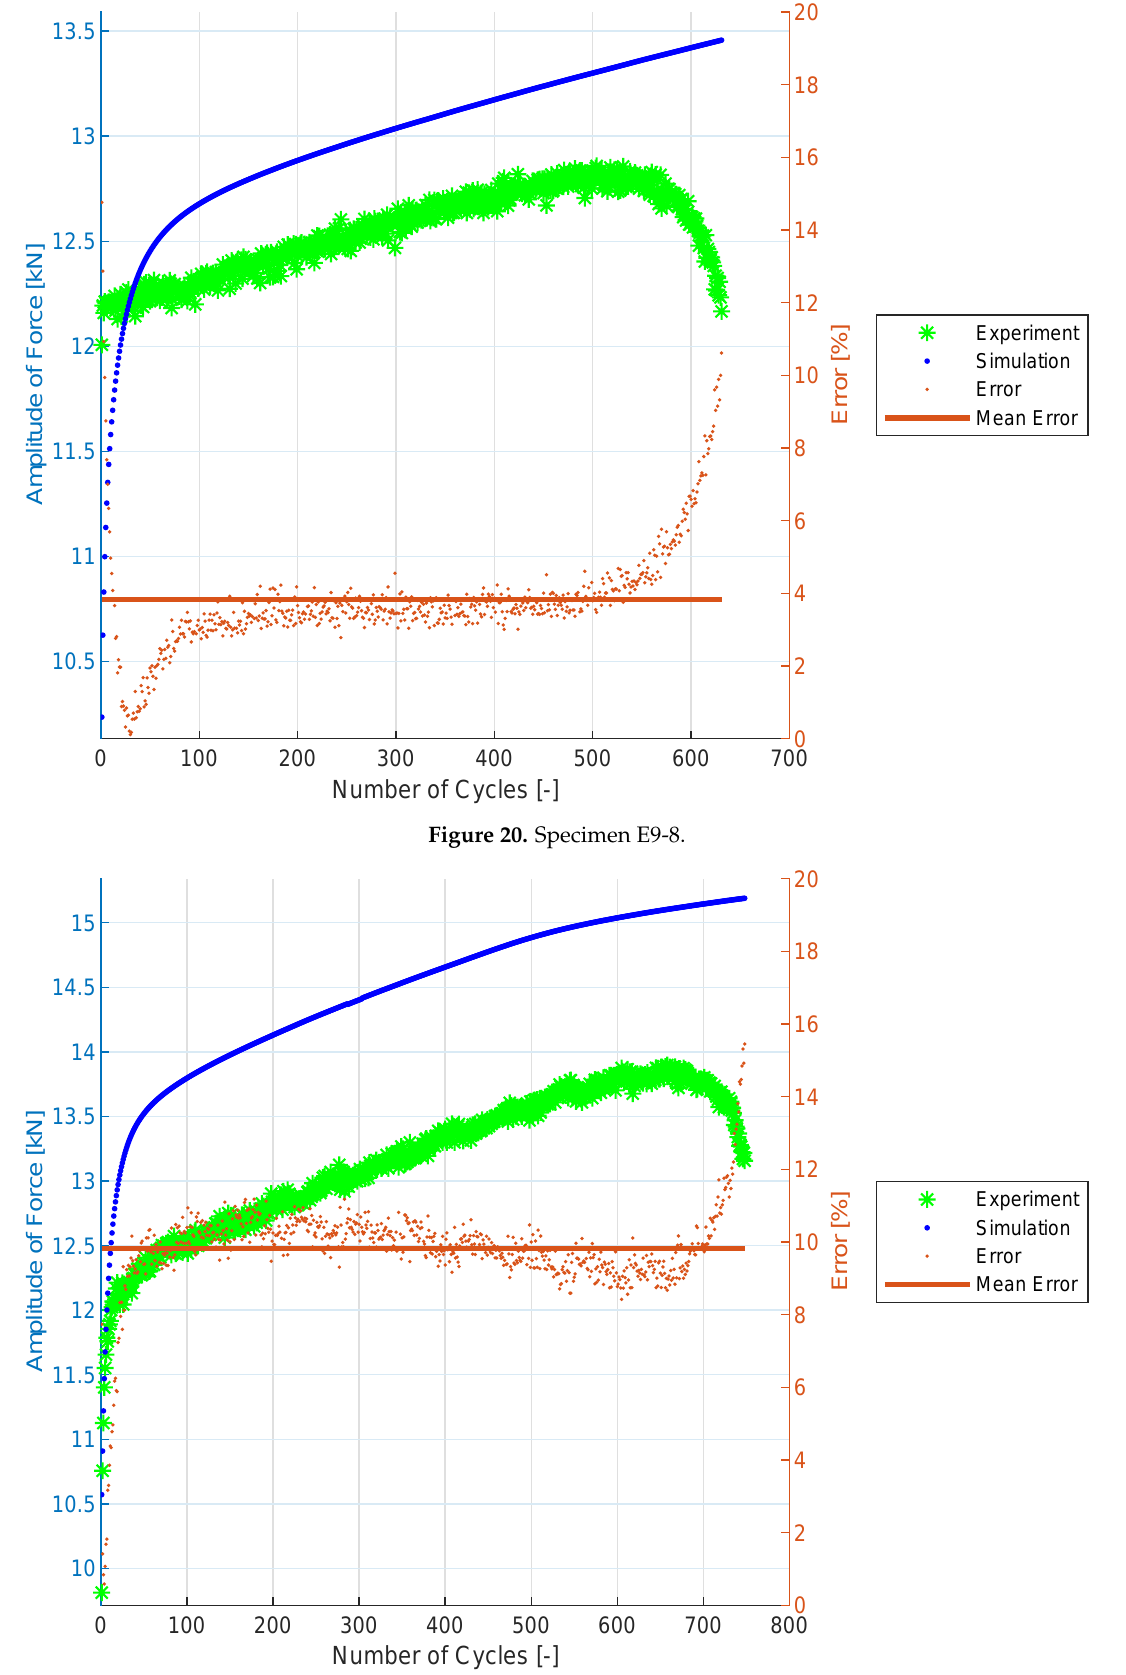
Figure 21. Specimen